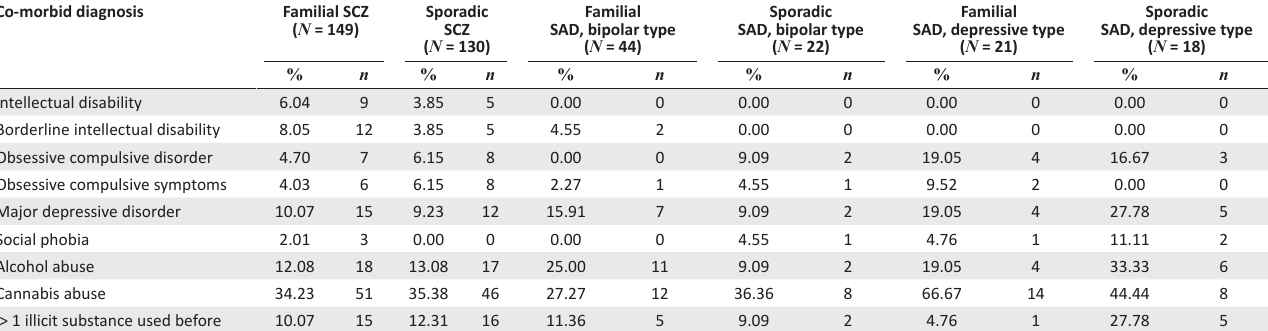
TABLE 1d: Demographic & clinical characteristics of 214 familial and 170 sporadic participants with a DSM diagnosis of schizophrenia or schizoaffective disorder. Co-morbid diagnosis